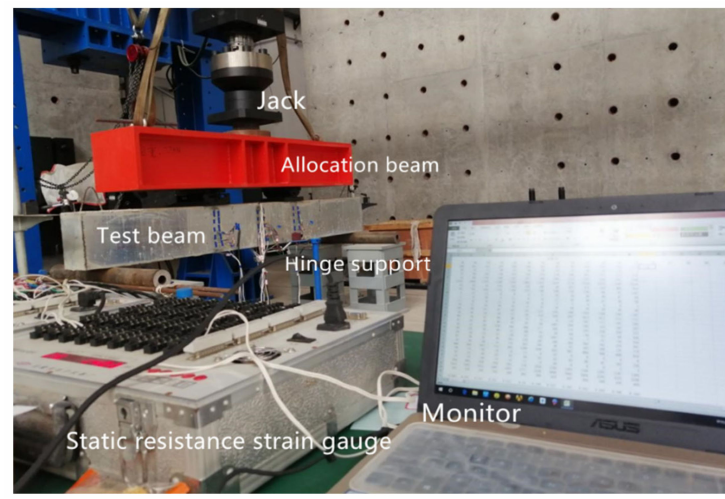
Figure 3. Diagram of the static load test test device.